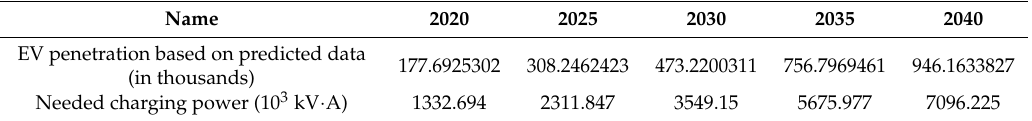
Table 6. Needed charging power of electric vehicles.